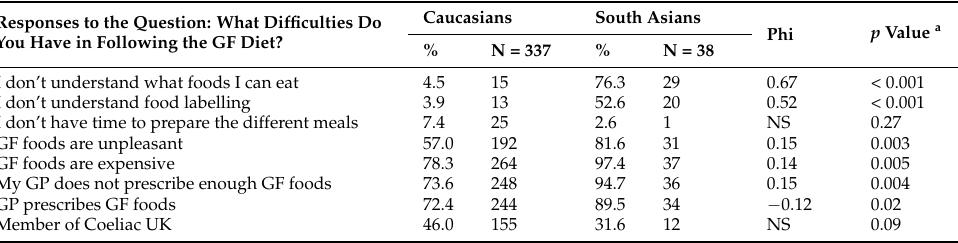
Table 3. Proportion of Caucasians and South Asians who agree with the statements relating to practical difficulties of adhering to a gluten free (GF)